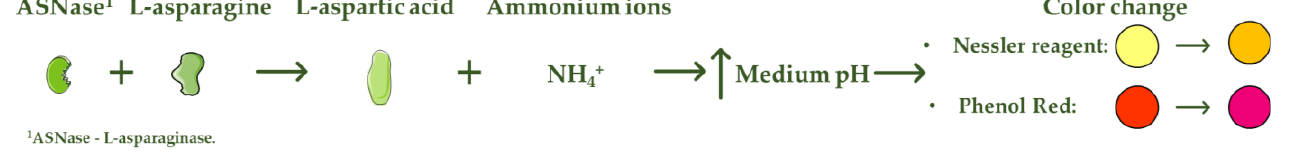
Figure 1. Mode of action of colorimetric ASNase based biosensors.